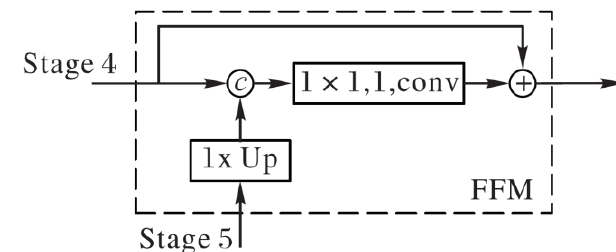
Figure 7. Feature fusion